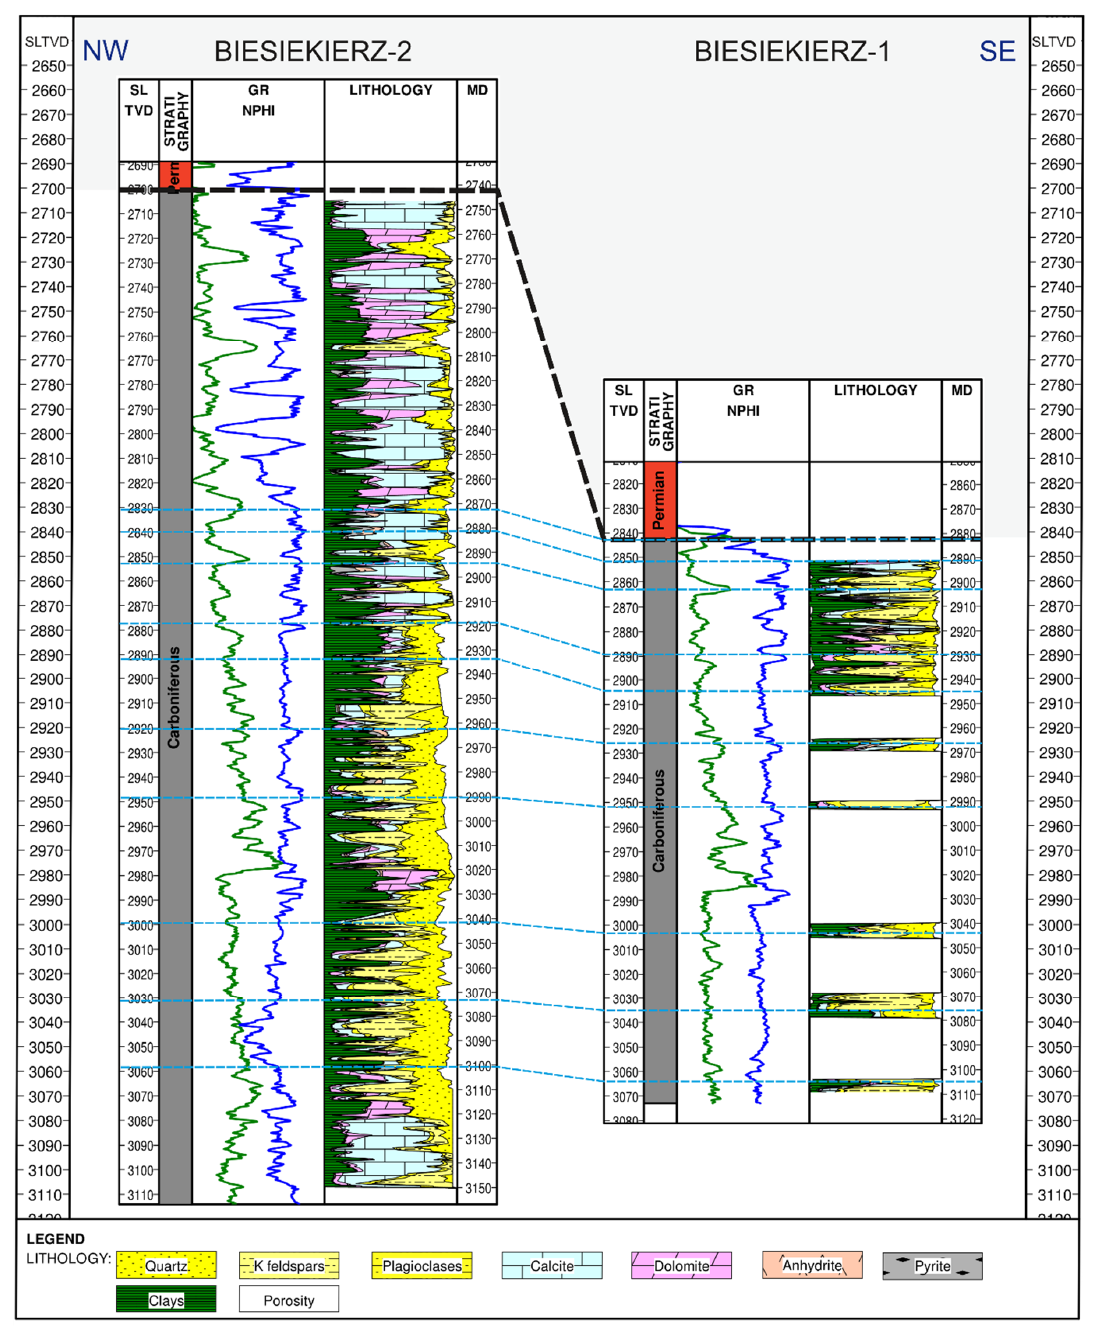
Figure 17. Correlative juxtaposition of the Biesiekierz-2 and Biesiekierz-1 boreholes. Intervals/levels considered correlative are marked with horizontal dotted lines on the graph.